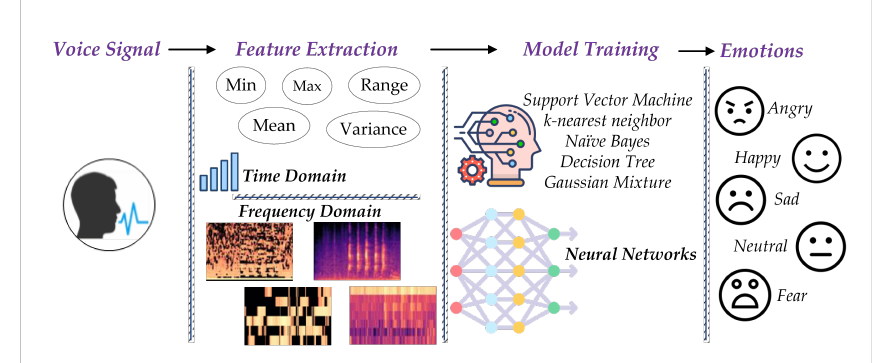
Figure 1. An illustration of the SER process using conventional